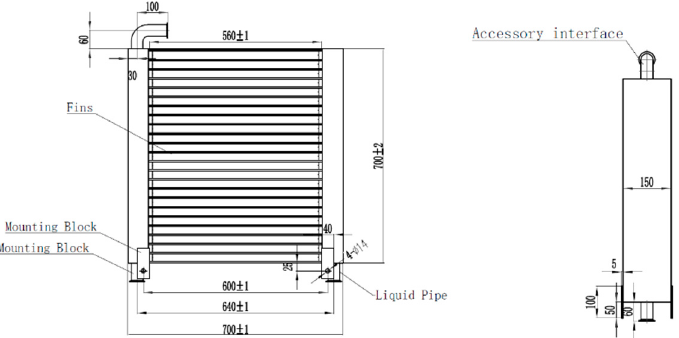
Figure 5. Condenser design drawing.